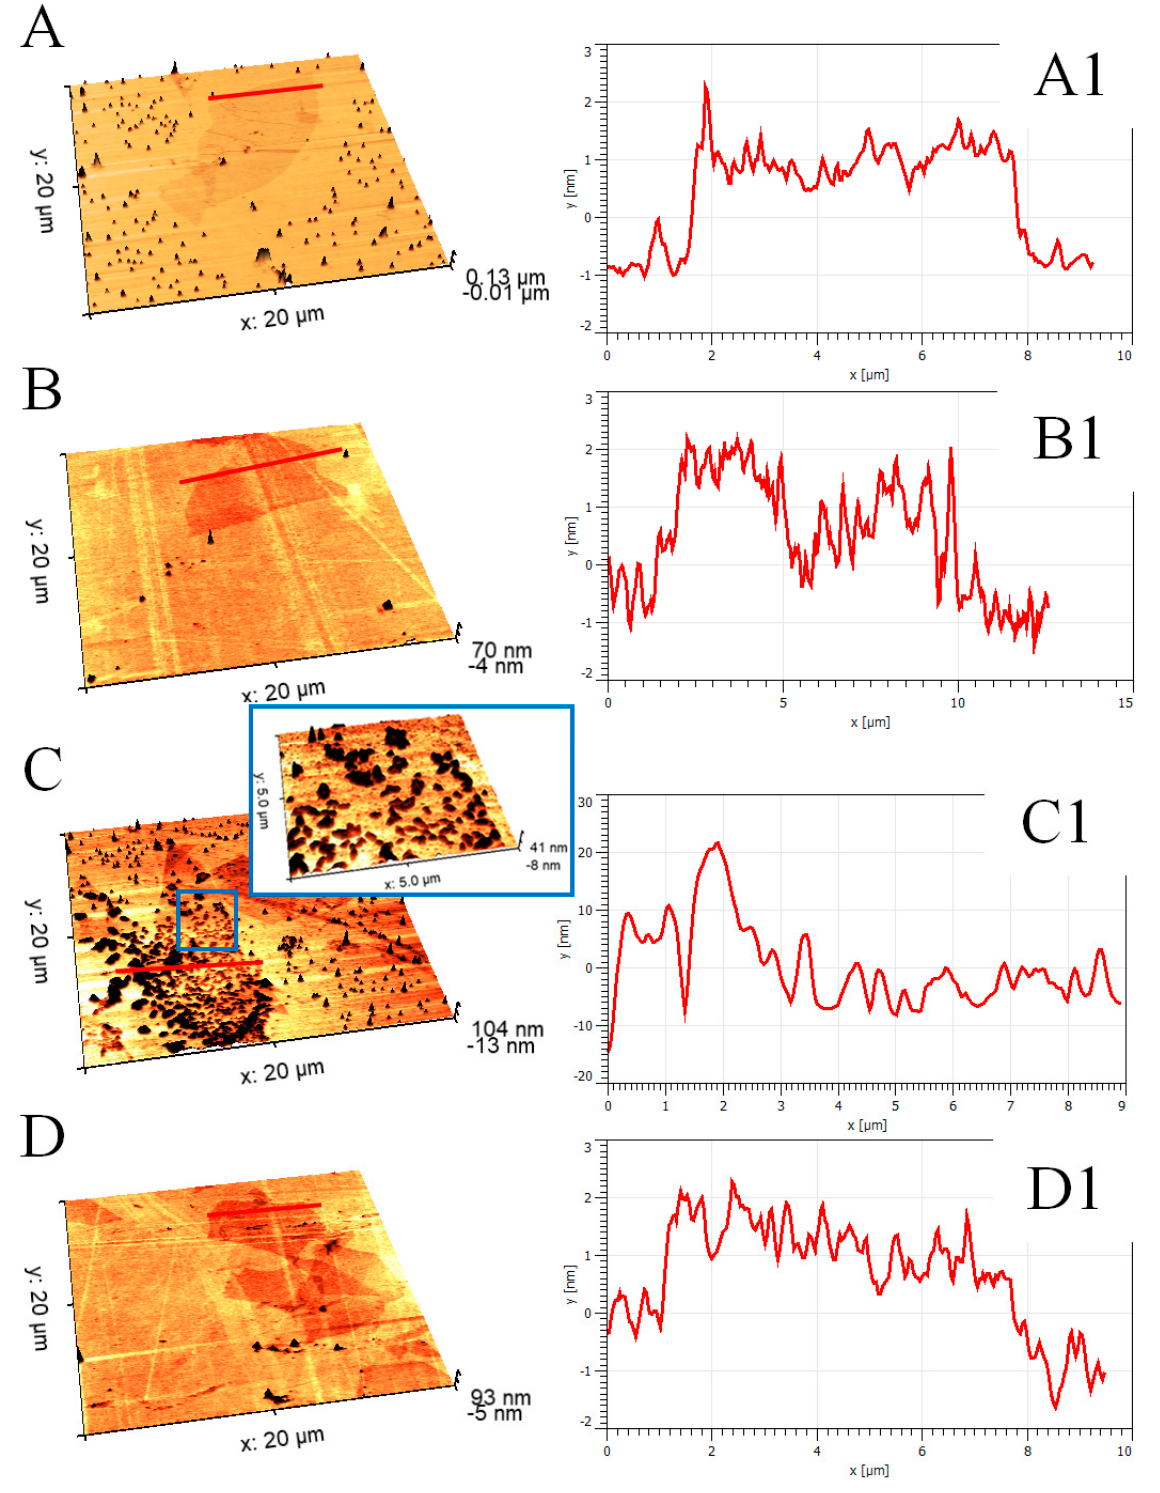
Figure 3. AFM topographical images of graphene oxide flakes: ( A ) as-obtained, ( B ) purified, ( C ) aged_as-obtained, ( D ) aged_purified, accompanied with their topographical profiles on images ( A1 , B1 , C1 , D1 ). The scanning area is 20 × 20 μ m. Red markers correspond to a place from which topographical profiles were taken.